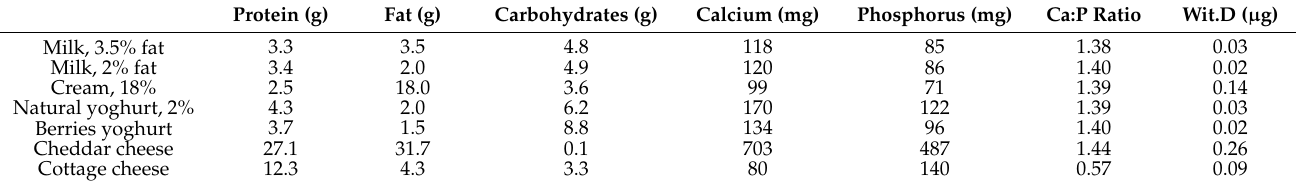
Table 4. Content of macronutrients, calcium, phosphorus and vitamin D in milk and dairy products [69]. Protein (g) Fat (g) Carbohydrates (g) Calcium (mg) Phosphorus (mg) Ca:P Ratio Wit.D ( µ g) Milk, 3.5%